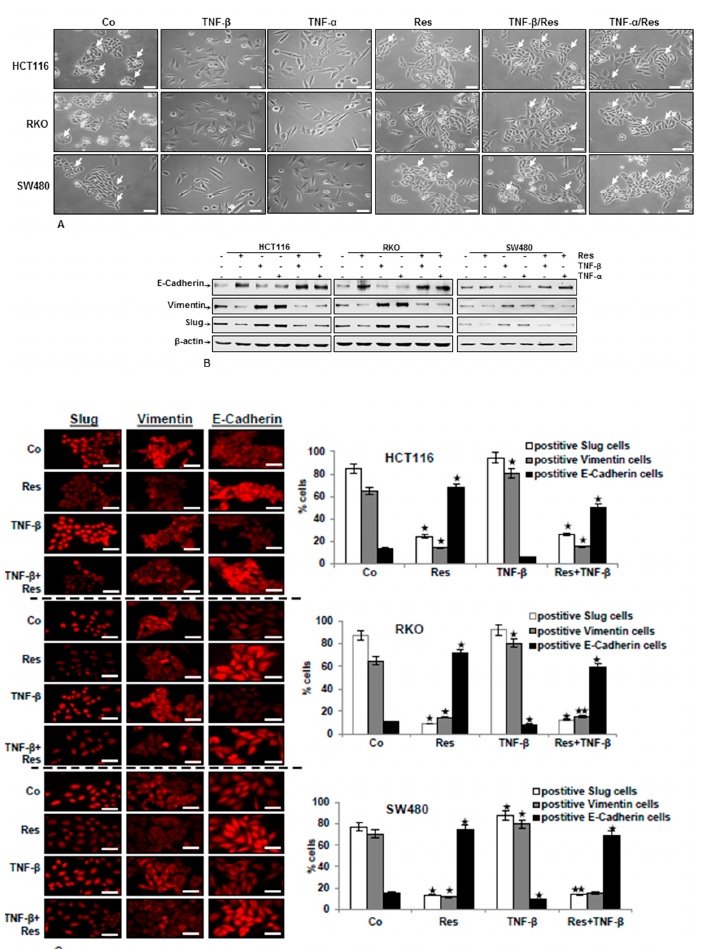
Figure 1. Impact of resveratrol on TNF- β -induced epithelial-to-mesenchymal transition (EMT) and EMT-related proteins in CRC cells (HCT116, RKO, SW480). CRC cells in monolayer culture were either left untreated (Co) or treated with 5 µ M resveratrol (Res), 10 ng/mL TNF- β , or 10ng/mL TNF- α for 12 h, or cells were pre-treated with resveratrol (5 µ M) for 4 h, followed by co-treatment with 10ng/mL TNF- β or 10ng/mL TNF- α for 12 h. ( A ) Cell phenotype changes associated with EMT, as demonstrated in phase contrast images. Cell colonies (arrows). Scale bar = 100 µ m. ( B ) Immunoblotting of cell lysates was performed for E-cadherin, vimentin, and slug. The housekeeping protein β -actin served as an internal loading control. ( C ) Immunolabeling was done with primary antibodies for E-cadherin, vimentin, and slug, followed by incubation with rhodamine-coupled secondary antibodies. All experiments were performed at least in triplicate and quantification of positively labelled cells was done by counting 600–800 cells from 10 microscopic fields. All data were compared to the control and statistically significant values with p < 0.05 were designated by (*) and p < 0.01 were designed by (**). Original magnification, 600 × . Scale bar = 30